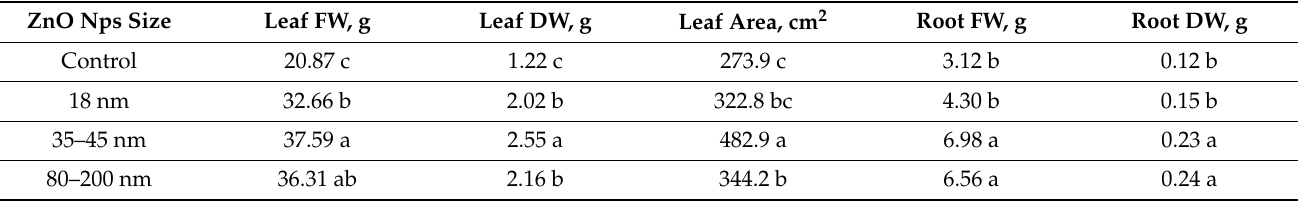
Table 2. Particle size-dependent effects of ZnO nanoparticles on Swiss chard growth characteristics: leaf fresh (FW) and dry weight (DW), leaf area and root fresh (FW) and dry weight (DW). Different letters represent significant differences. The data were processed using analysis of variance (ANOVA) and the Tukey (HSD) multiple range test at the confidence level p =